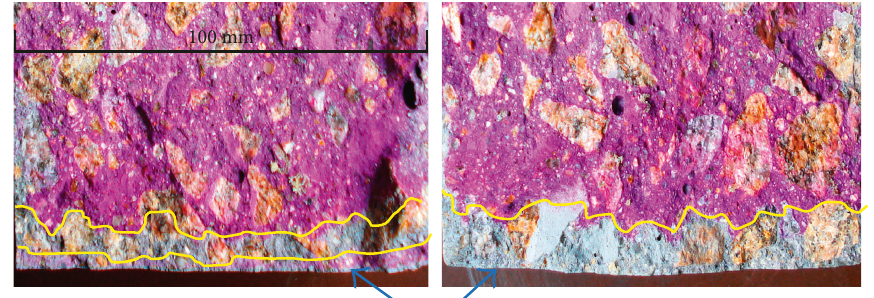
Figure 3: Determination of carbonation depth in surface-impregnated (left: G400) and reference untreated concrete specimens (right: Ref.).